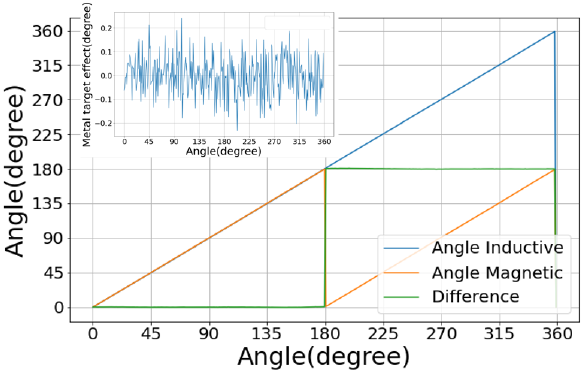
Figure 7. Angle response curves of the magnetic and inductive sensors. The inset shows the difference between the two magnetic measurements: with and without the metallic target. The difference is random, indicating that the magnetic sensor accuracy is not impacted by the metallic